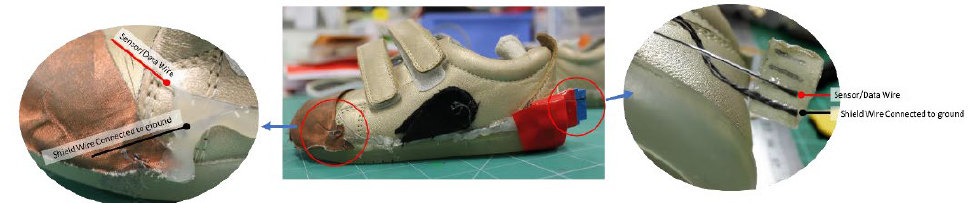
Figure 14. ( Left ) Connections from the sensor and shield layer on the toe cap; ( Middle ) Overview of the grounded heel shoe; ( Right ) Connections of wires attached to a Z -axis tape.